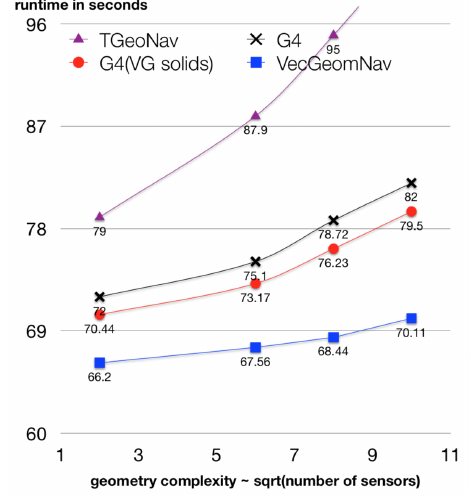
Figure 5. Benchmark of Geant4 simulation in a large volume of thin gas filled with a varying number of polycones, using di ff erent navigation options: Geant4 navigator with native solides (G4), Geant4 Navigator with VecGeom solids "G4 (VG Solids)", TGeo Navigator ("TGeoNav") and the VecGeom Navigator ("VecGeomNav"). The x-axis is the square root of the number of volumes. Error bars are on the order of the size of the symbols but are not included